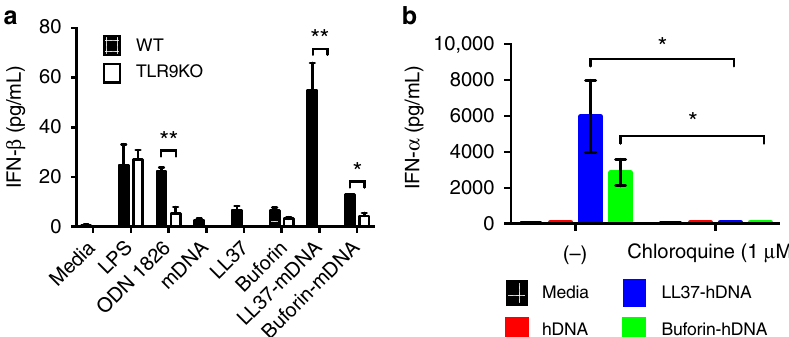
Fig. 5 LL37-double-stranded DNA (dsDNA) and buforin-dsDNA complexes induce type 1 interferon (IFN) production in a TLR9-dependent manner in mouse macrophages and human plasmacytoid dendritic cells (pDCs). a To measure the ability of AMP-dsDNA complexes to activate TLR9, complexes were incubated with wild-type (WT) and TLR9-knockout (TLR9KO) murine macrophages. IFN- β production was measured and quanti fi ed from supernatants using a Bio-ELISA. Mouse genomic dsDNA was used to generate the complexes. Data show TLR9-dependent activation of WT macrophages by LL37-dsDNA and buforin-dsDNA complexes, with minimal to no activation with peptides or dsDNA alone. As a positive control, mouse-speci fi c TLR9 agonist ODN 1826 was used. Both WT and TLR9KO cells responded to the TLR4 agonist lipopolysaccharide (LPS) ( n = 3, * p < 0.05, ** p < 0.01). b Similarly, AMP-dsDNA complexes were incubated with human pDCs in the absence or presence of chloroquine (1 µ M), and IFN- ɑ production was quanti fi ed with enzyme-linked immunosorbent assay (ELISA). Data show that pDCs potently release IFN- ɑ in a TLR9-dependent manner in response to LL37-dsDNA and buforin-dsDNA complexes, and this response is attenuated in the presence of chloroquine, which inhibits endosomal acidi fi cation and TLR speci fi c signaling ( n = 2, * p < 0.05). Error bars denote s.e.m. Group comparisons were calculated using pairwise two-tailed t